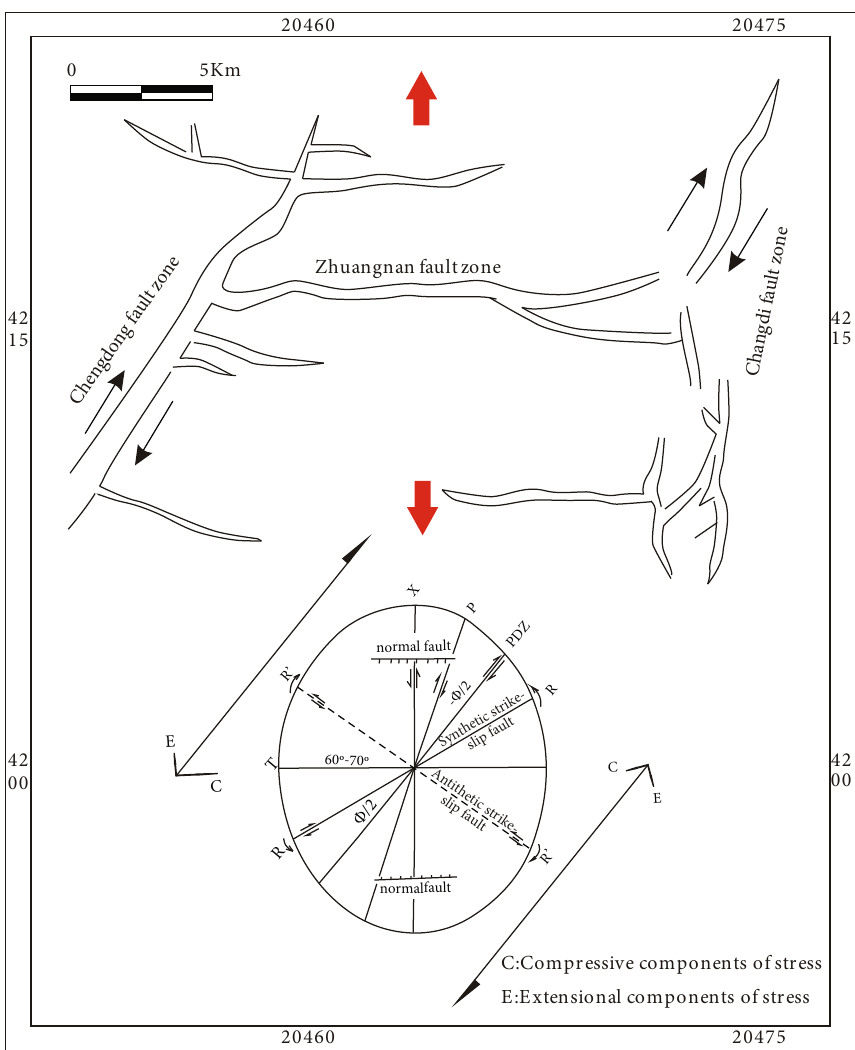
Figure 11: Tectonic stress fi eld of Zhuangnan fault